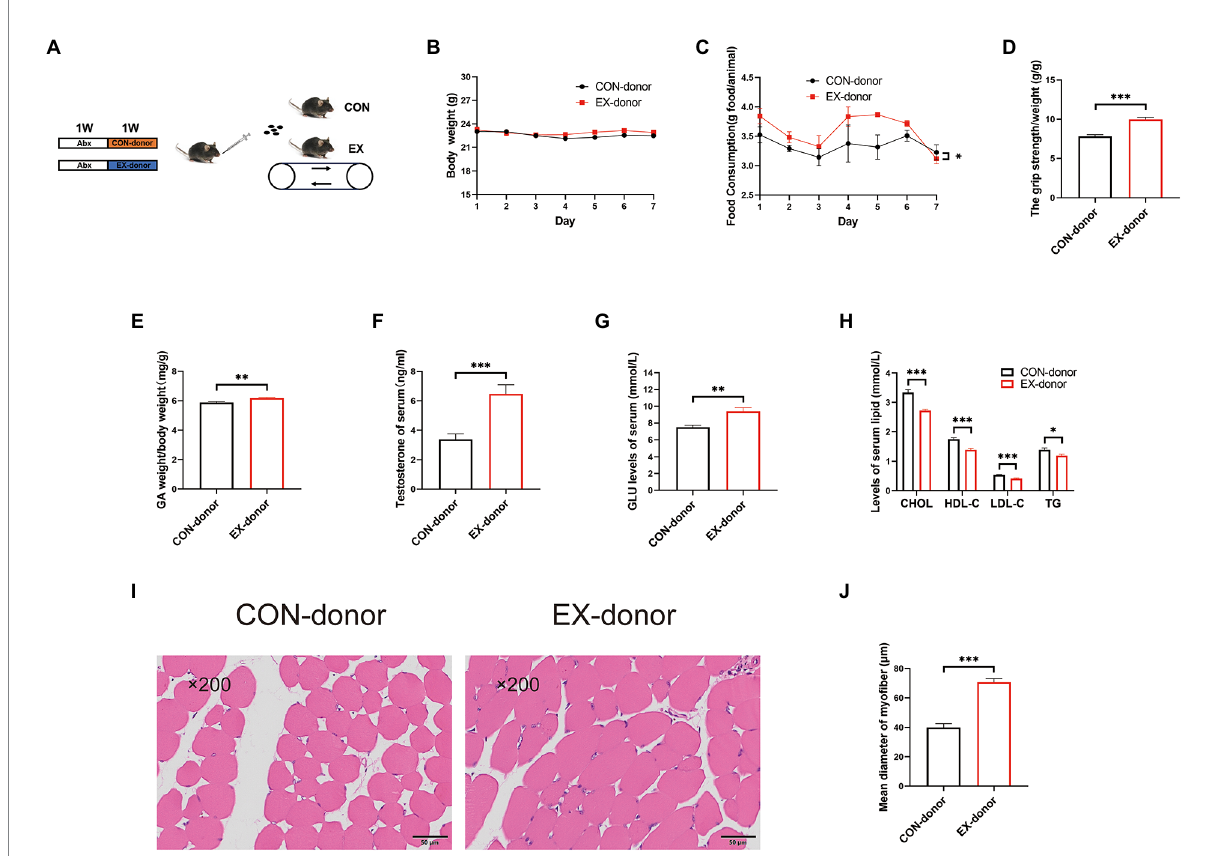
FIGURE 5 The gut microbiota played a key role in skeletal muscle performance (CON-donor, EX-donor). (A) Mice were subjected to FMT for 1 week. (B) Body weight. (C) Food intake. (D) Grip strength. (E) GA percentage. (F) Testis percentage. (G) Serum GLU levels. (H) Serum lipids levels. (I) HE staining of the skeletal muscle. (J) Mean diameter of the myofiber ( ∗ p < 0.05; ∗∗ p < 0.01; ∗∗∗ p <